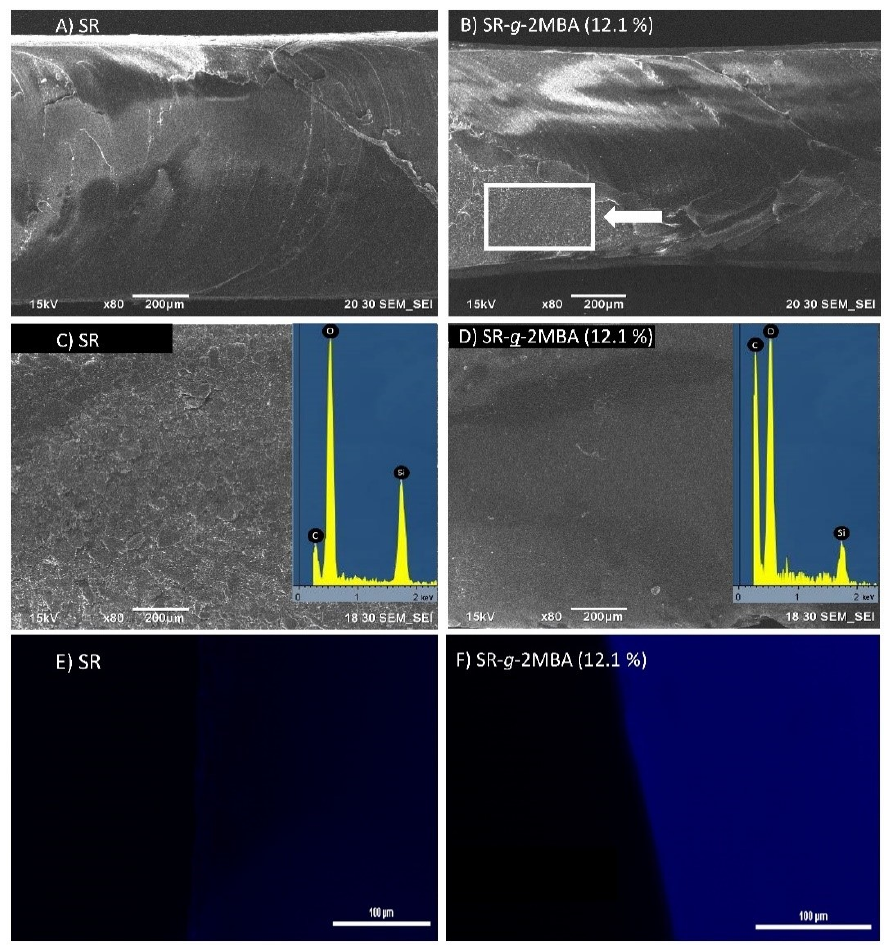
Figure 3. Scanning electron microscope (SEM) images of the cross-sections of ( A ) SR and ( B ) SR- g - 2MBA 12.1%, the surfaces of ( C ) SR and ( D ) SR- g -2MBA 12.1%, and the surface fluorescence